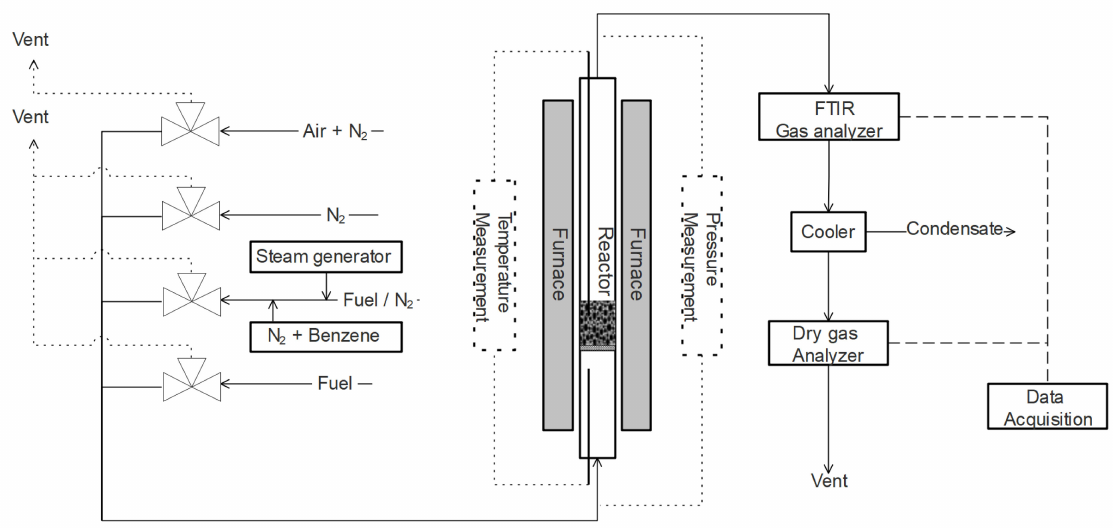
Figure 4. Schematic overview of the batch fluidized bed reactor